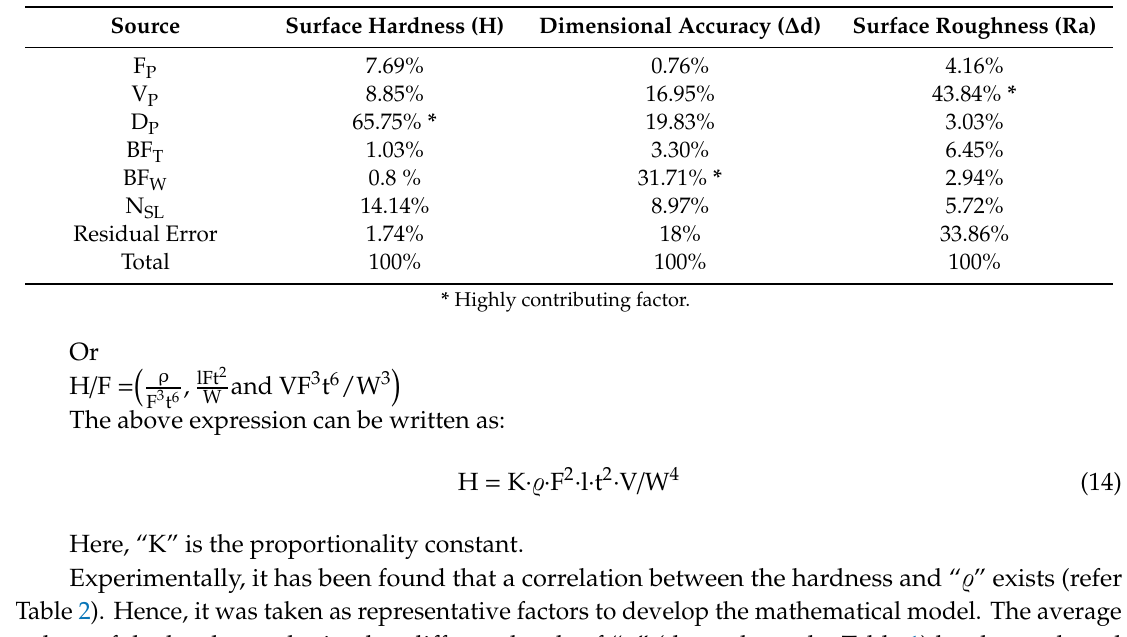
Table 2. Percentage contribution of input process parameters.